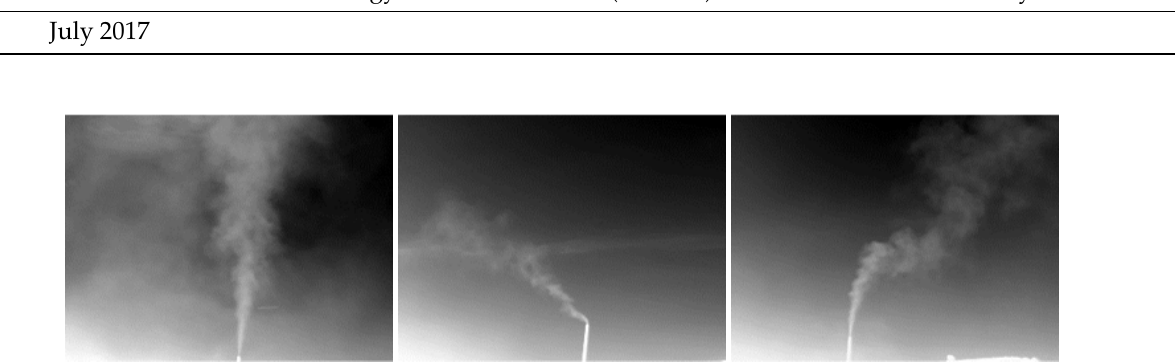
Figure 4. Sample photos of the GasVid dataset.